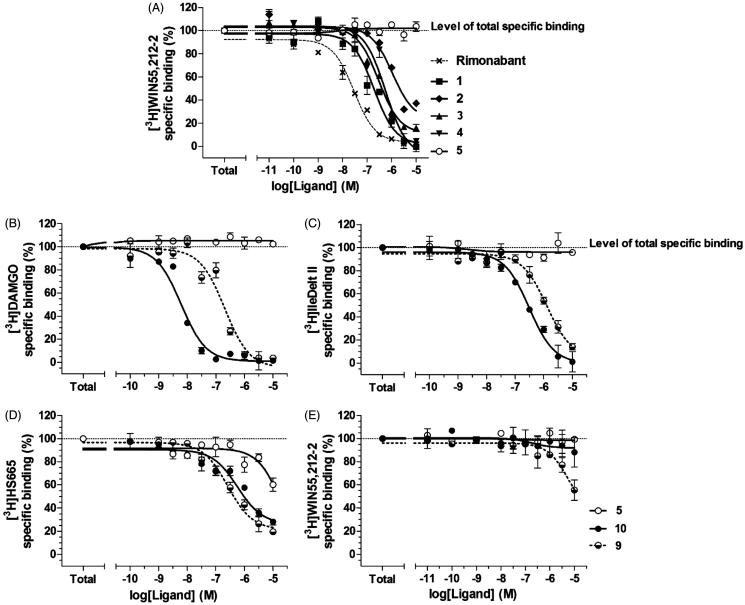
The binding affinity of Rimonabant and its analogs on CBR (A) and the MOR (B), DOR (C), KOR (D) and CBR binding affinity of 5, 9 and 10 (Tyr-D-Ala-Gly-Phe-NH2) (E) in competition binding experiments. Figures represent the specific binding of [3H]WIN55 212–2, [3H]DAMGO, [3H]IleDelt II and [3H]HS665 in percentage in the presence of increasing concentrations (10 −11–10−5 M) of the indicated unlabeled ligands performed in rat (A, B and E) or in guinea pig (D) whole brain membrane homogenates. “Total” on the x-axis indicates the total specific binding of radioligand, which is measured in the absence of the unlabeled compounds. The level of total specific binding was defined as 100% and is presented with a dotted line. Points represent means ± SEM for at least three experiments performed in duplicates.